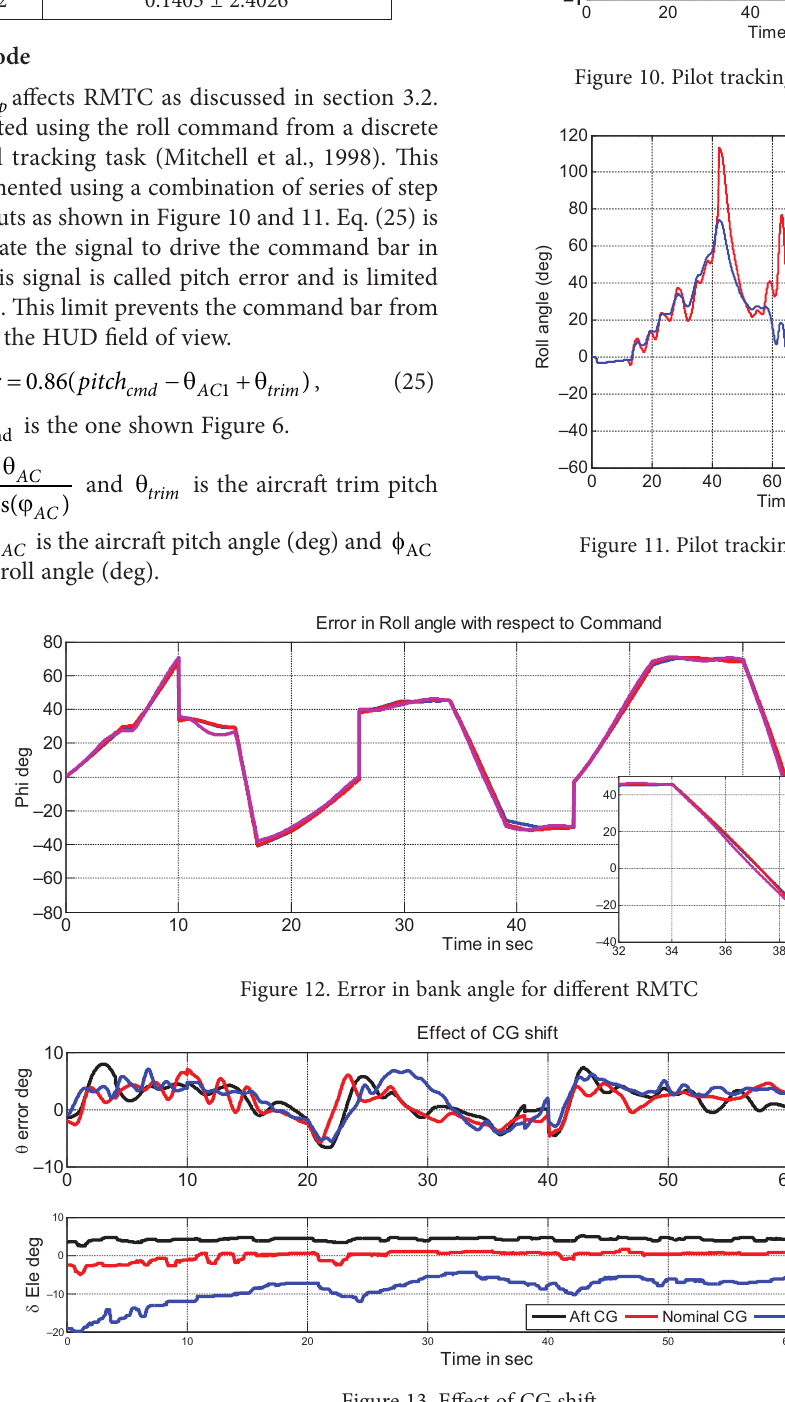
Figure 13. Effect of CG